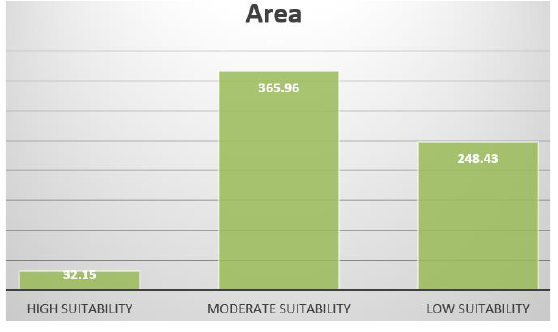
Figure 3. Total area in